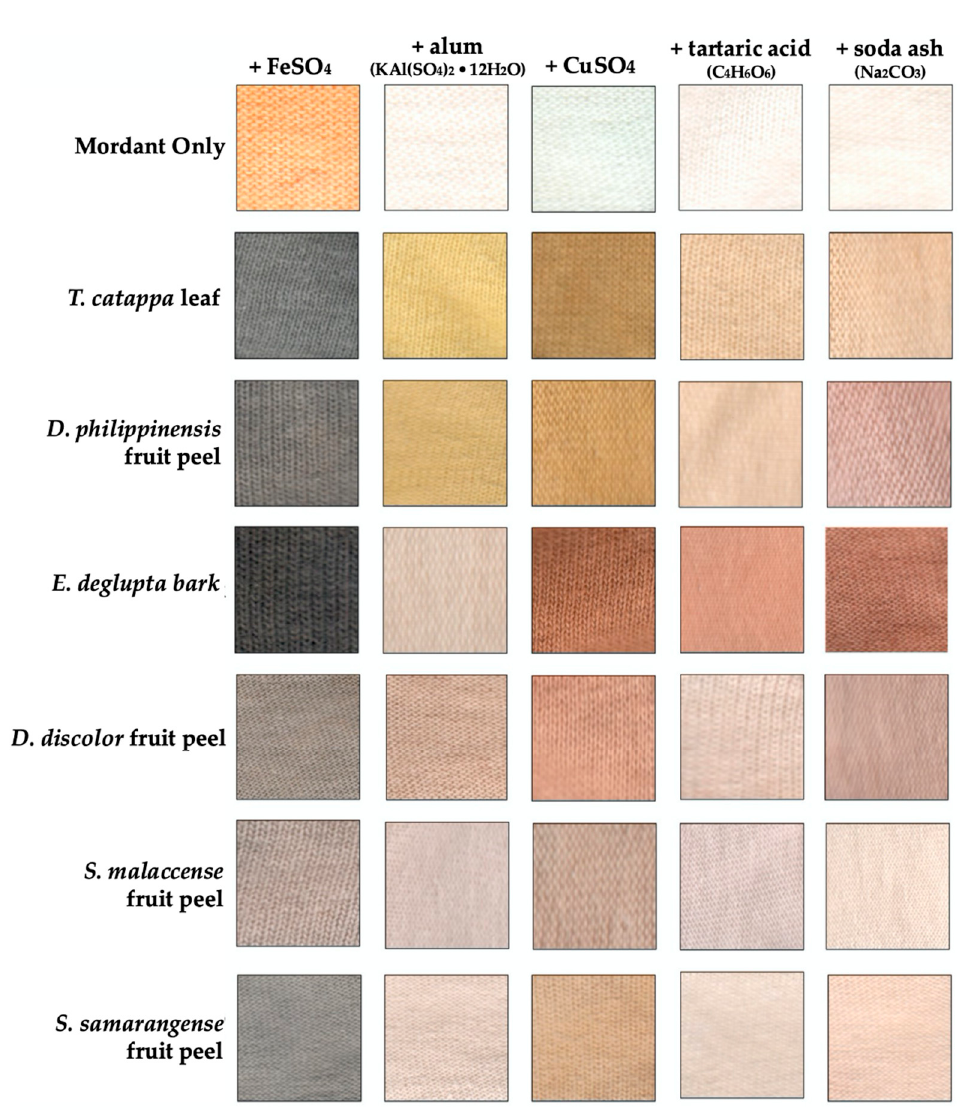
Figure 3. Color palette from the biowaste dyes applied in cotton using different mordants. Comparison of color is through the measured hue (color component), value (lightness), and saturation (intensity). Lighter color (low %V value) is obtained in the presence of FeSO 4 , especially for E. deglupta and T. catappa (both black). D. philippinensis extract mordanted with alum also produced yellow comparable to the well-studied T. catappa . Interestingly, red-brown coloration was uniquely observed in E. deglupta with CuSO 4 or alkali.